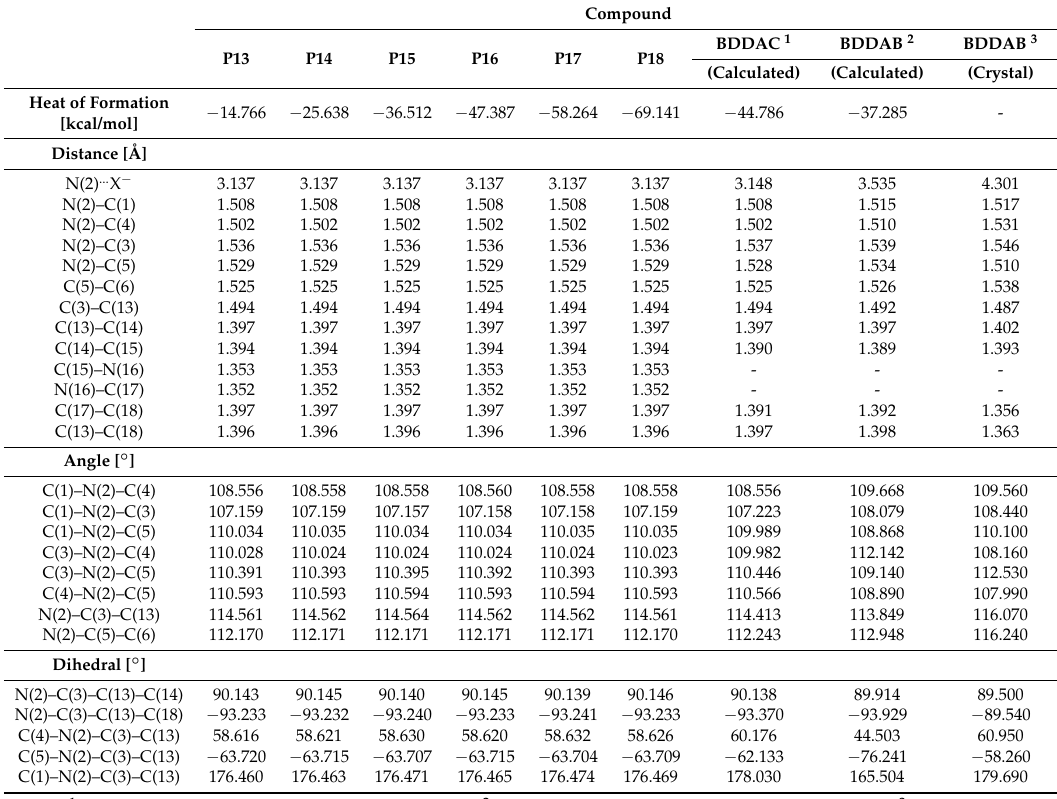
Table 1. HOF, bond lengths and angles for P13 – P18 , BDDAC and BDDAB.